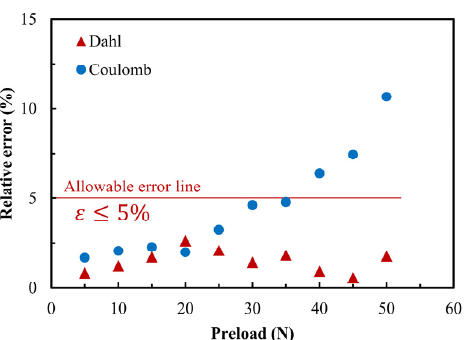
Figure 14. Comparative analysis of relative error of output velocity based on preload change for Dahl and Coulomb friction models. The bold black line reads the reference line, and the blue line reads the allowable error line in engineering sense.